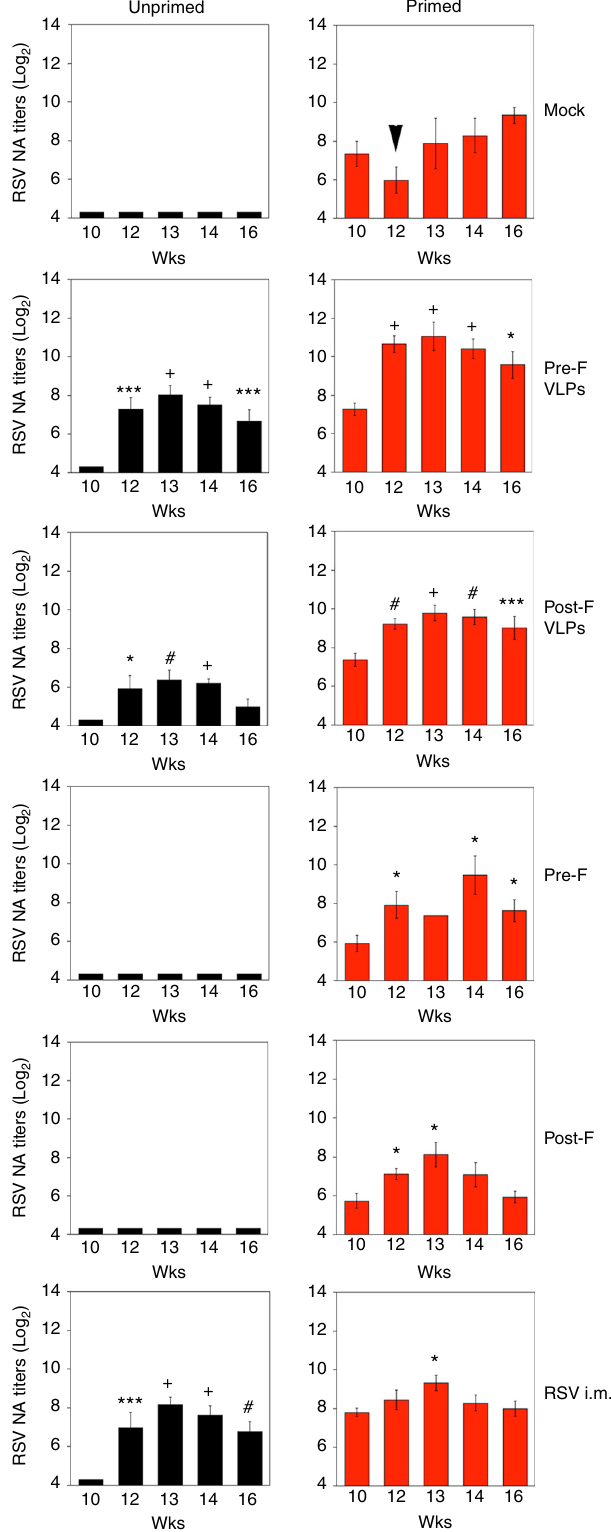
whereas week 12 samples represent sera taken before delivery (B.D.) of